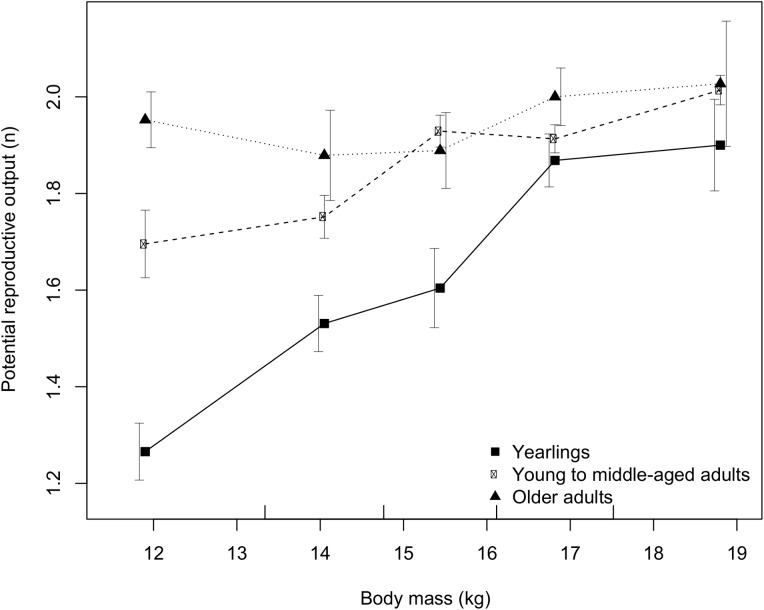
Potential reproductive output (number of CL, including infertile individuals) of roe deer females in relation to body mass by age category.Age categories are as follows: yearlings (15–19 months old), young to middle-aged adults (2–7 years old), and older adults (8+ years old). Samples were pooled based on the body mass of individuals into five groups with an equal number of units across the total sample set (for intervals, see marks above the X axis). In the case of the first and the last body mass groups, dots are horizontally positioned on the mean body mass of all individuals in these two groups. Error bars denote 95% confidence intervals of the mean.